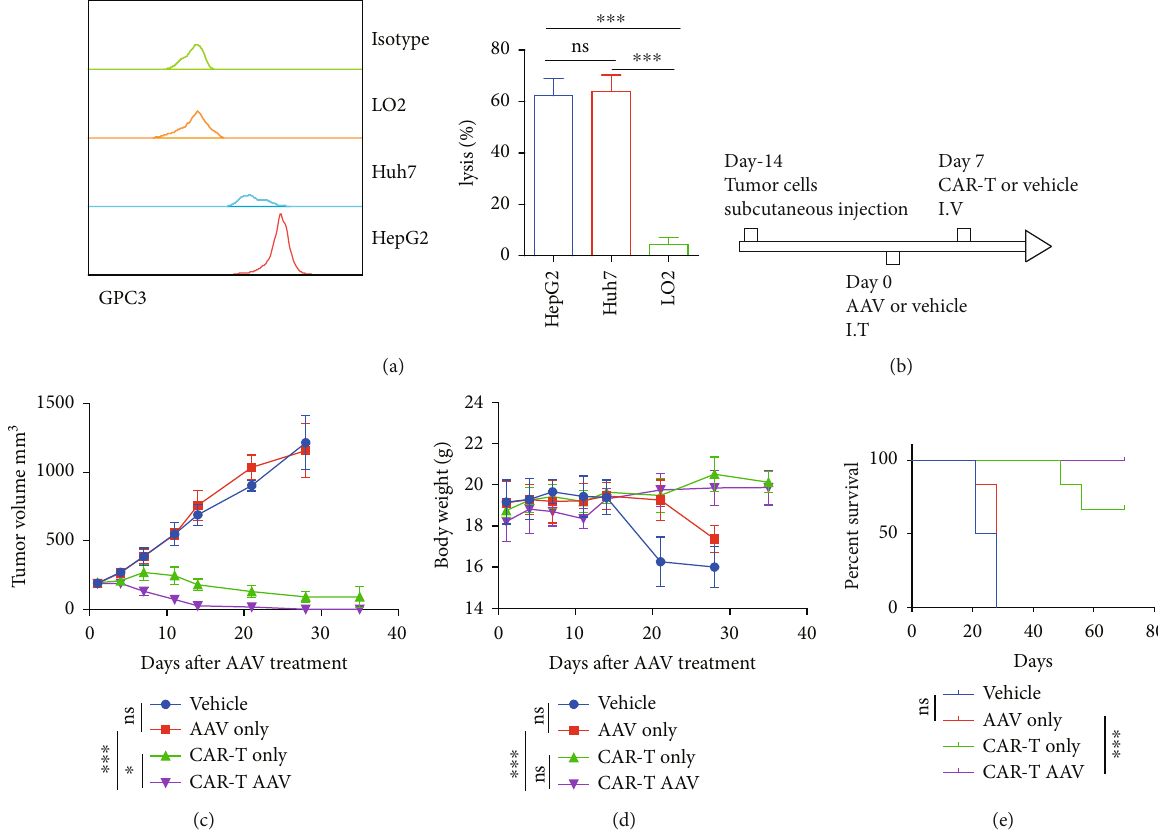
Figure 4: Tumor-suppressive activity of AAV-CCL19 and GPC3 CAR-T. (a) GPC3 expression on the surface of tumor cells detected by FACS and GPC3 CAR-T tumor lysis activity analysis in vitro; (b) schedule of in vivo tumor suppressor activity analysis; (c) in vivo tumor suppression curve; (d) body weight curve; (e) survival curve for mice. Error bars represent mean ± SD ( n = 5 ); ns: no signi fi cant di ff erence, ∗ P < 0 : 05 , ∗∗∗ P < 0 : 001